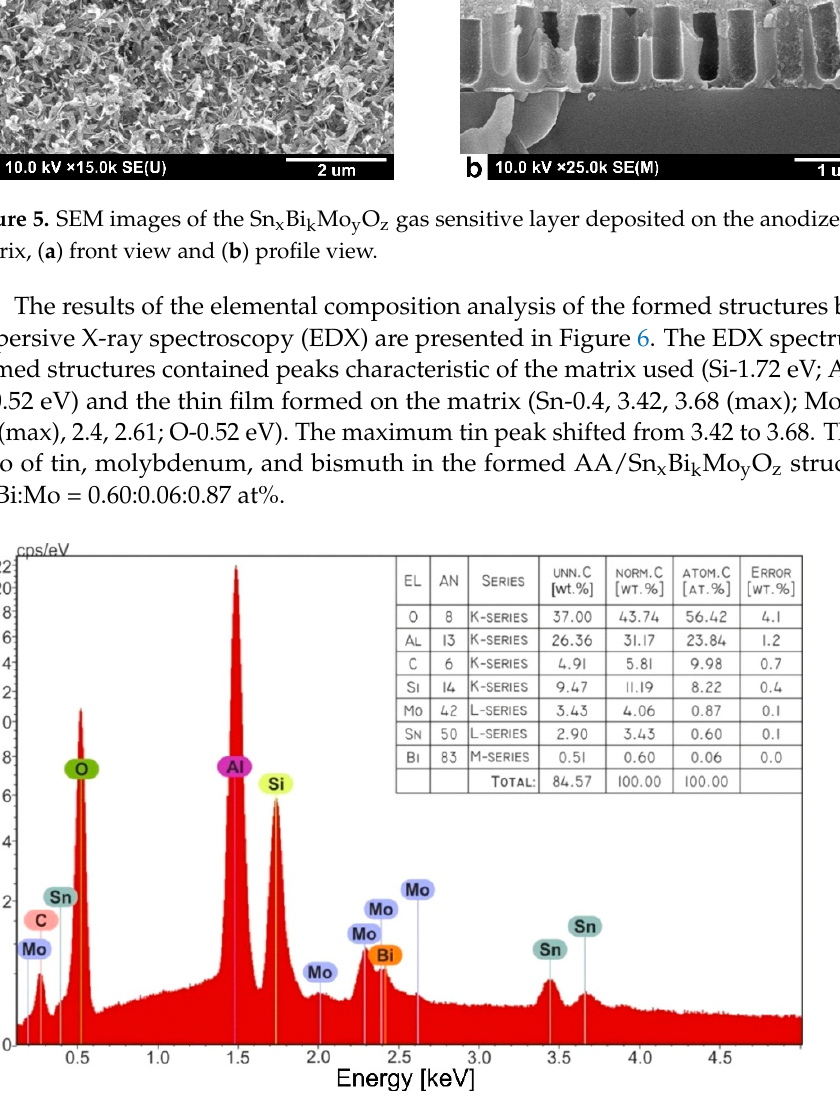
Figure 6. EDX results of prepared AA/(Sn x Bi k Mo y O z ) structure; the insert table presents the analysis details.